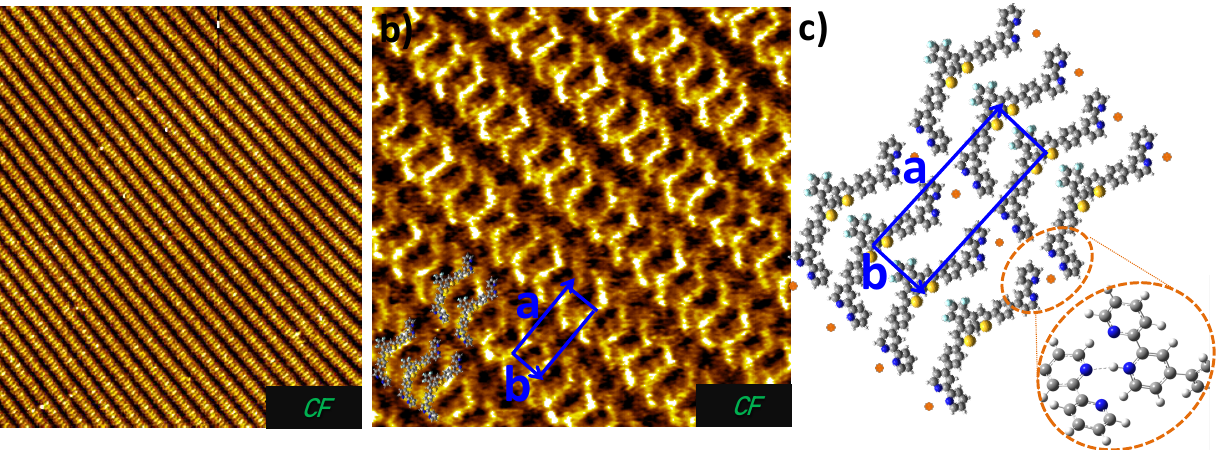
Figure 1. STM images of CF bpy-DAE-bpy isomers at 1-heptanoic acid/HOPG interface, I t = 40–50 pA, U s = − 0.5 V: ( a ) large-scale: 100 × 100 nm 2 . ( b ) High-resolution: 14 × 14 nm 2 . ( c ) Proposed model of the stripe structure where the orange balls represent